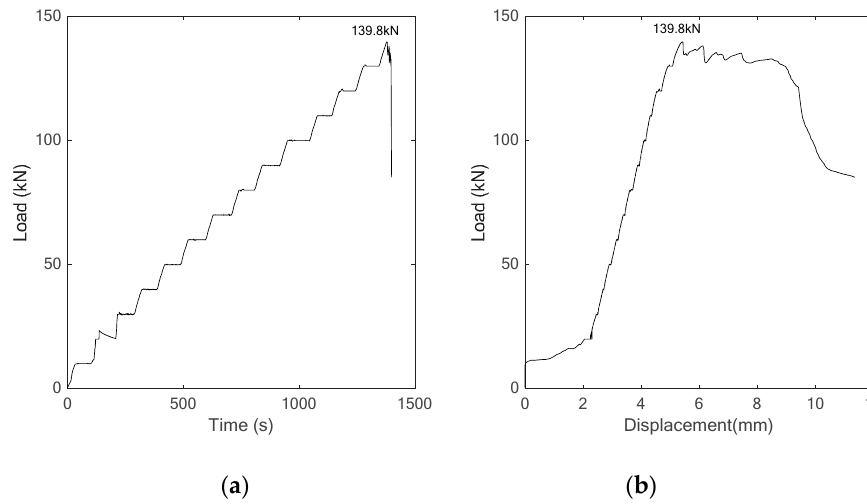
Figure 18. The curves of ( a ) time vs. load, ( b ) displacement vs. load.